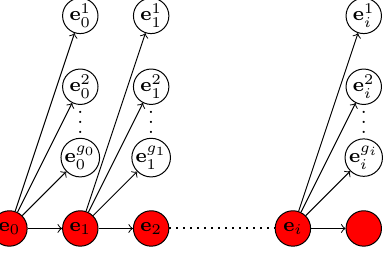
Figure 1: Visualization of error chains. White and red nodes indicate error patterns that can and cannot be decoded, respectively. Starting from an undecodable error pattern e 0 , we successively generate several new error patterns e g by swapping a randomly chosen 0 0 and 1 in e 0 . Once a new undecodable error pattern e 1 is found, it is used as the new base for generating new error patterns. By iterating this procedure, we end up with a (red) chain of undecodable error